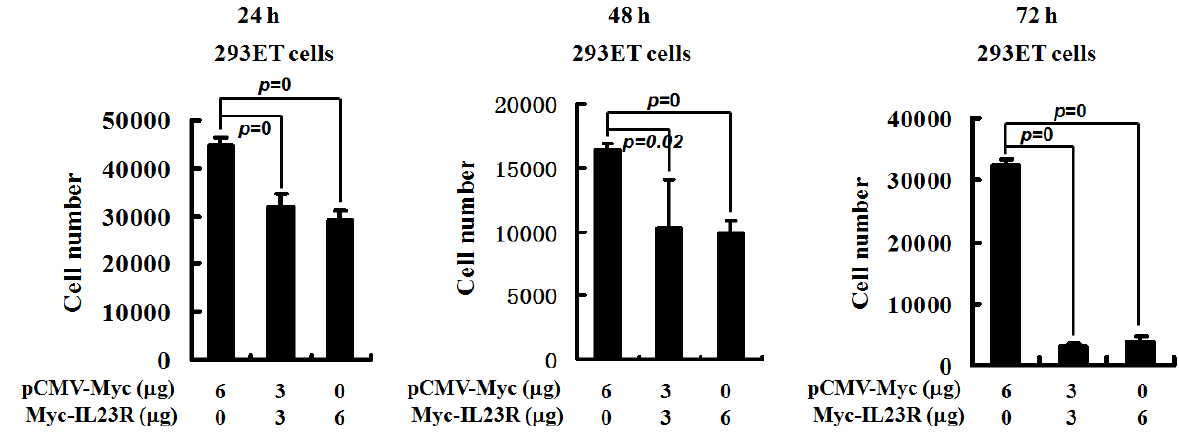
Figure 1. IL-23 receptor (IL-23R) inhibited the proliferation of transformed human embryonic kidney cell line 293ET cells. 293ET cells were transfected with increased doses (0, 3 and 6 µg) of IL-23R for 24, 48 and 72 h. The transfected cells were collected and assayed by CCK-8 kit. The reaction products were measured at 450 nm with a plate reader. The cell number for each dose was calculated using the established standard curve. The values represented as the mean ± SD from three to four independent experiments for each dose. Statistic analysis was performed with student’s t test. Statistical difference was considered to be significant if p <